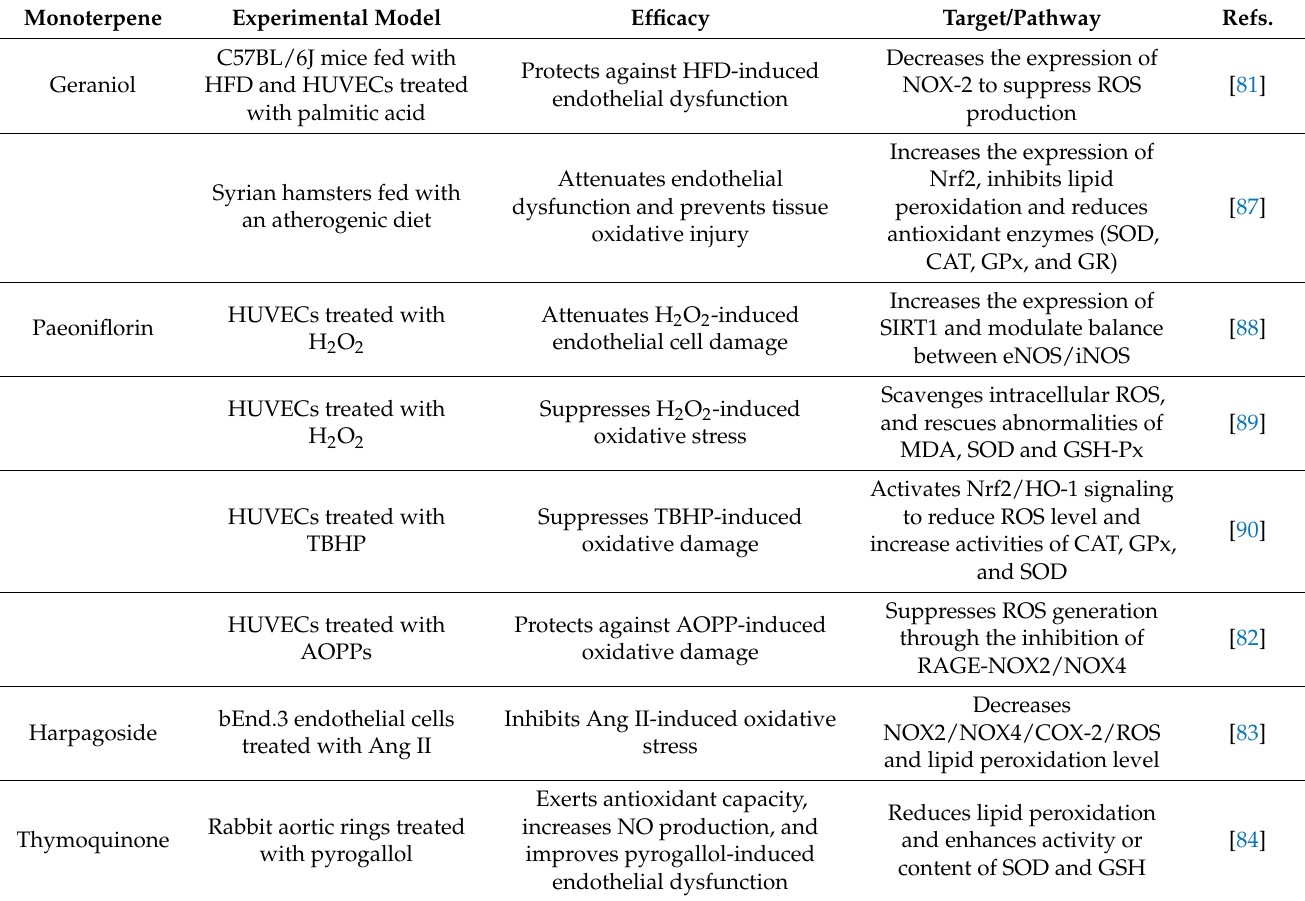
Table 3. Inhibition of endothelial oxidative stress and modulation of nitric oxide